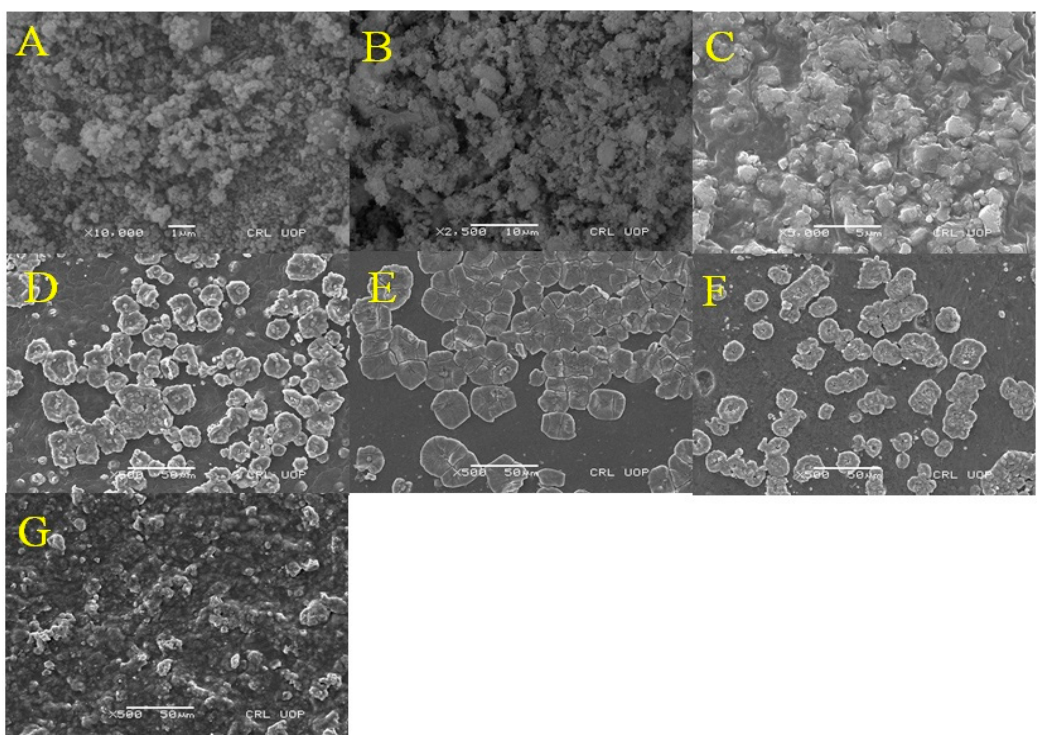
Figure 1. SEM images of IONPs ( A ), IONPs@SiO 2 ( B ), MCM-PA@B ( C – G ), IONPs@SiO 2 1:PA@B1